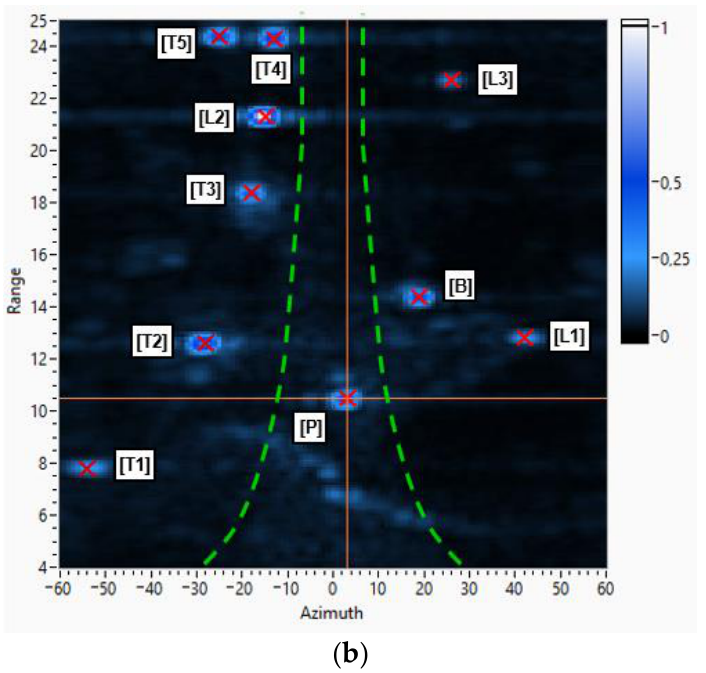
Figure 5. ( a ) Test scenario with a person placed at 10 m. ( b ) Acoustic image with detected targets.